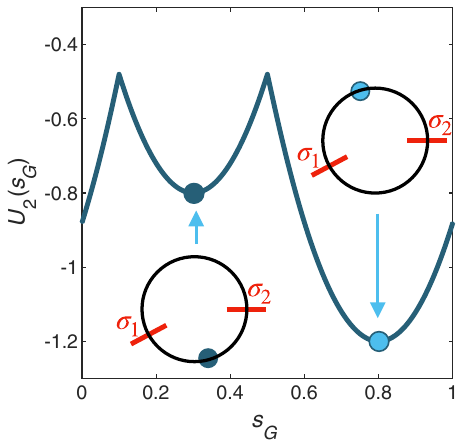
FIG. 7. Equilibrium positions of s G . Effective potential U 2 ð s G Þ trapping the position of s G along the strip when two identical shear stresses are applied at positions s 1 , s 2 . The blue circles indicate the two locally stable positions of s G . U 2 is minimized when s G is maximally distant from the applied stresses. Illus- tration with s 1 ¼ 1 = 10 and s 2 ¼ 1 = 2 and σ 1 ¼ σ 2 ¼ K .